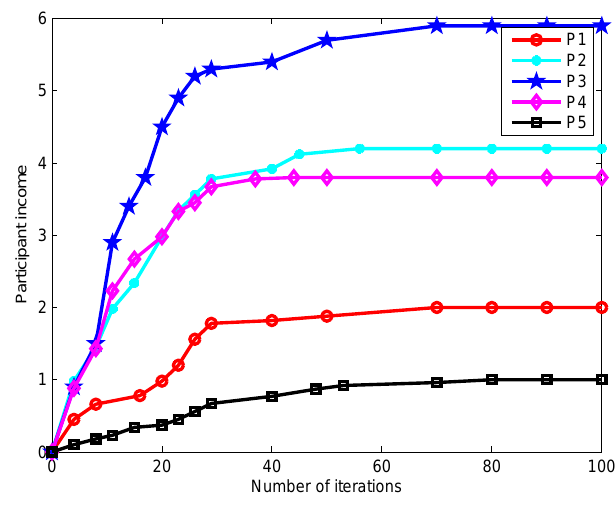
Figure 9. Changes in participant income.